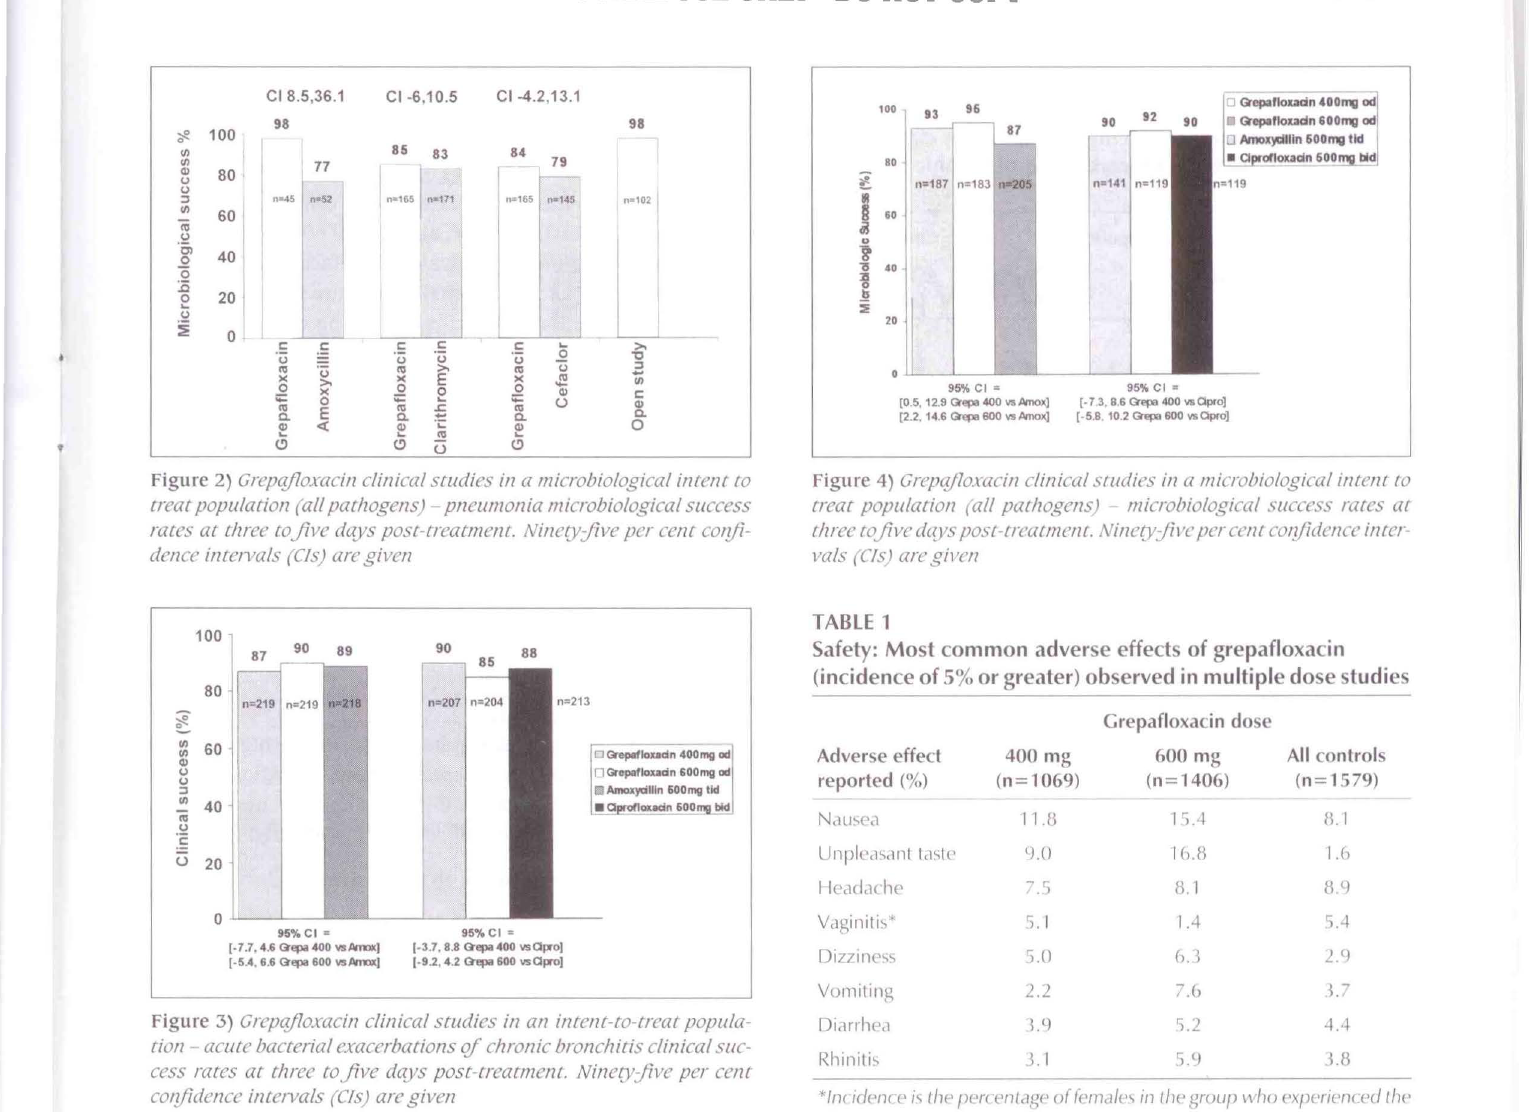
Figure 3) Grcpefloxacin clinical studies i11 an intent-to-treat popula rion acll{C baccerial exacerbations ef chronic bronchitis clinical suc cess rares ar three to.five dqys post-treatment. Ninetyjive per cent co,ifidencc inte,va/s (Cls) are given